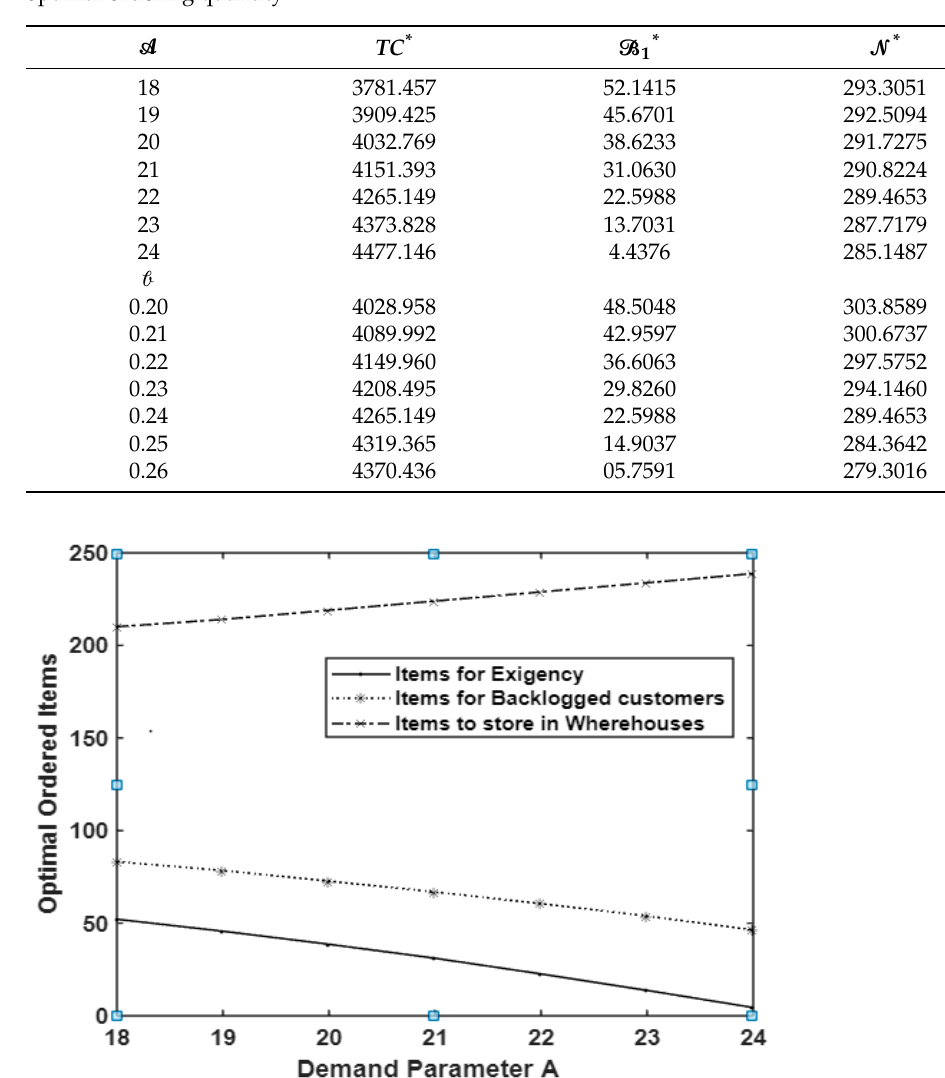
Figure 4. The effect of changes in demand parameter 𝒜 on optimal ordering items.